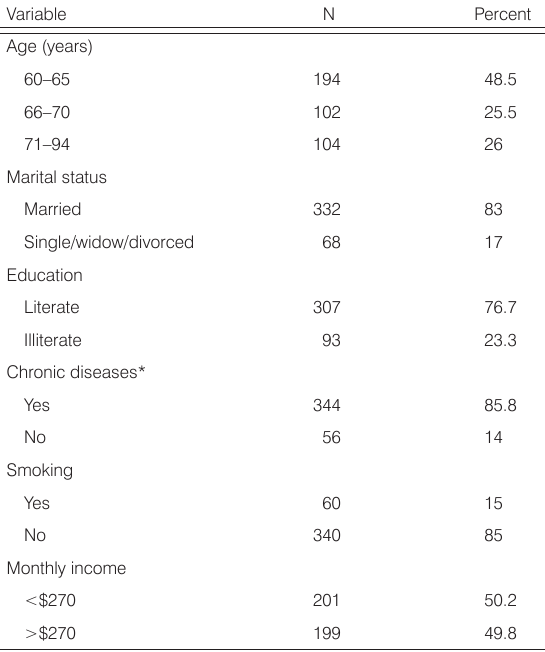
Table 1. Demographic profile of participants ( n =